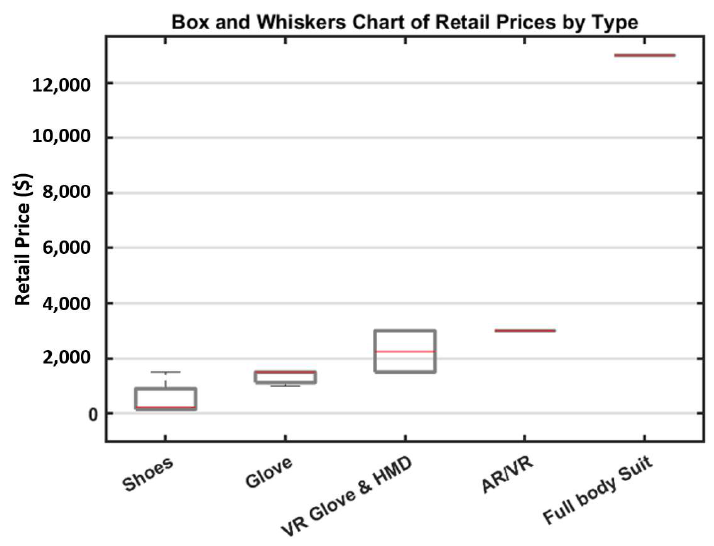
Figure 6. A box and whisker plot showing the retail price of the commercial haptics